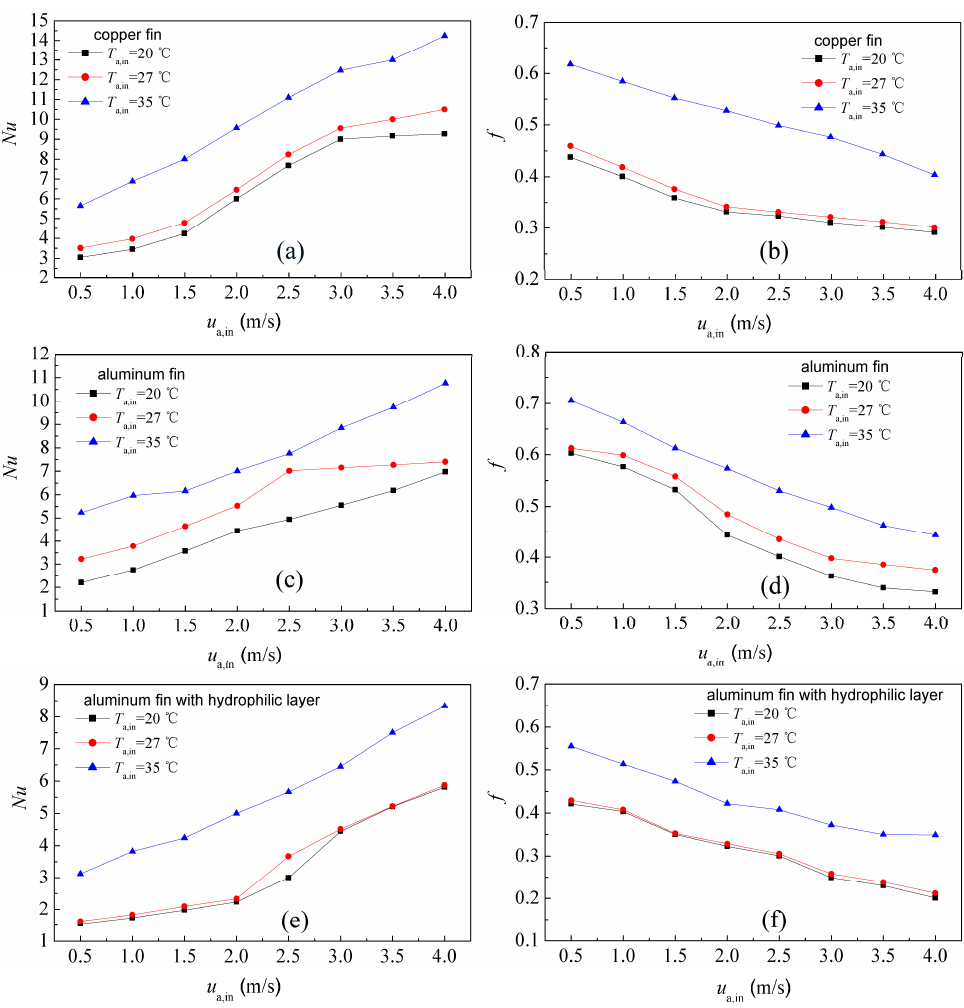
Figure 9. Effect of T a,in on Nu and f of three different fin materials: ( a , c , e ) Nu , ( b , d , f ) f .